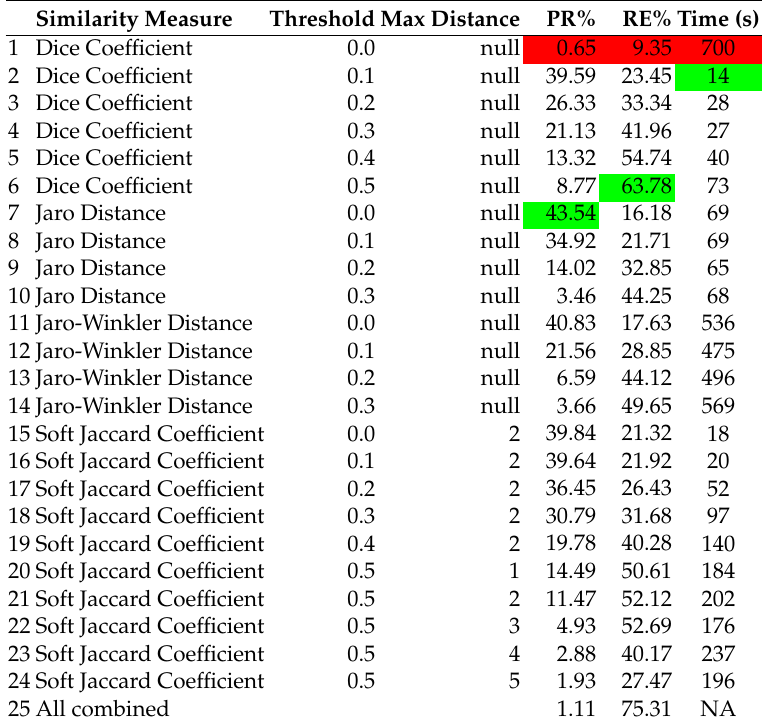
Table 1. Values marked with red and green, are the worst and best measure in each metric respectively. Similarity